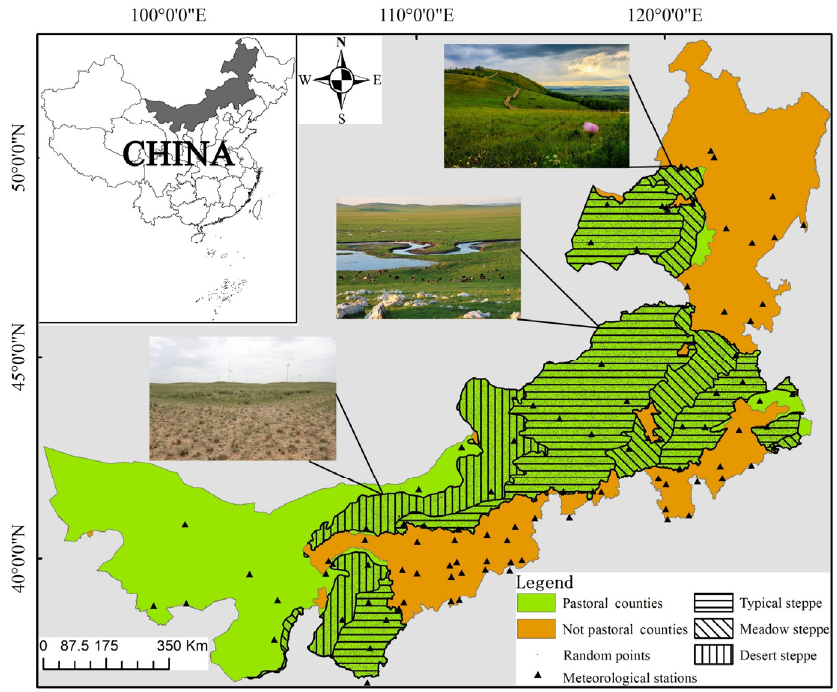
Figure 1. Inner Mongolian pastoral areas of different steppe types and the locations of meteorological stations.